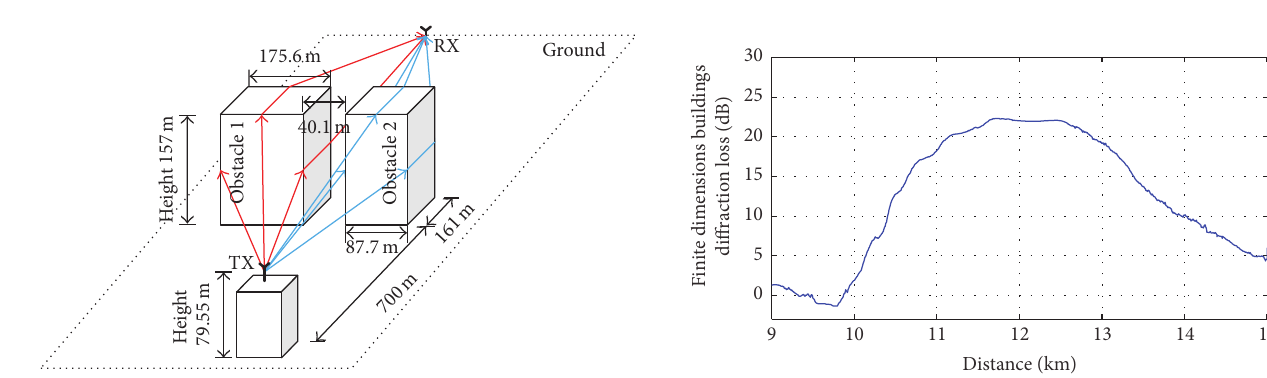
Figure 15: Diffraction loss caused by obstacle 2 in measurement 2.